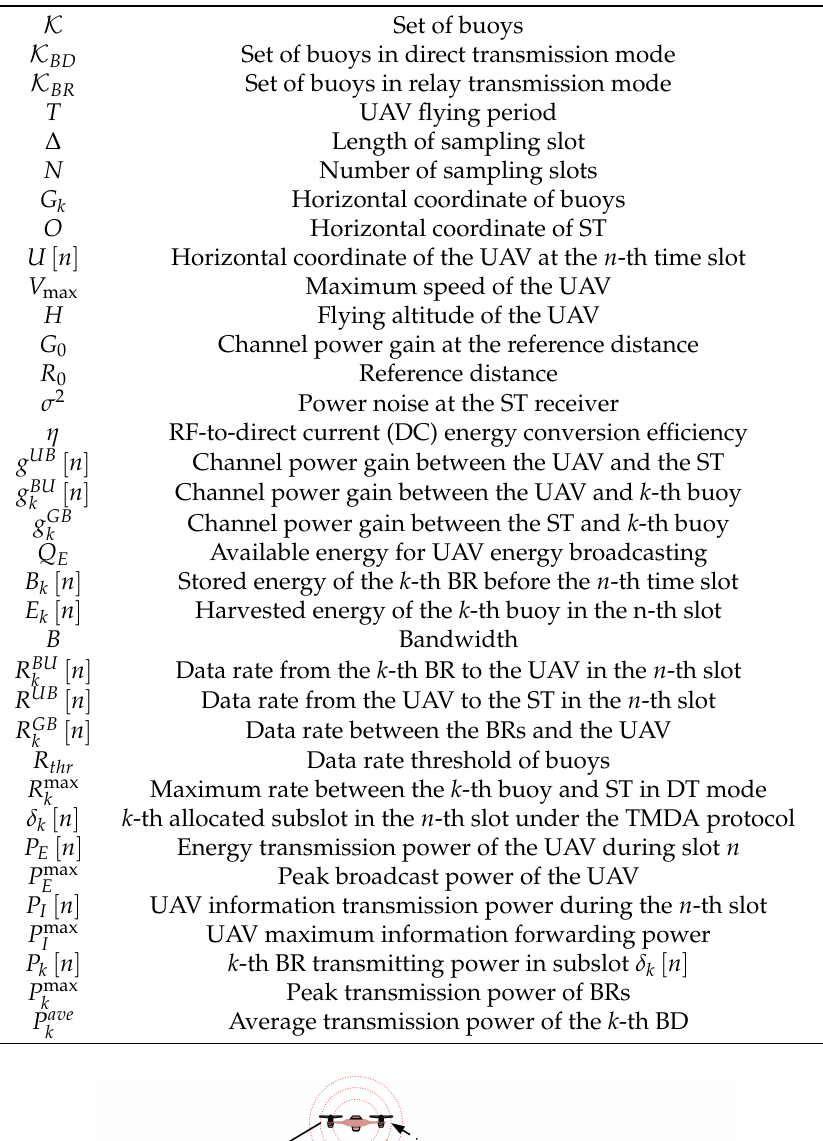
Table 1. List of main symbols.